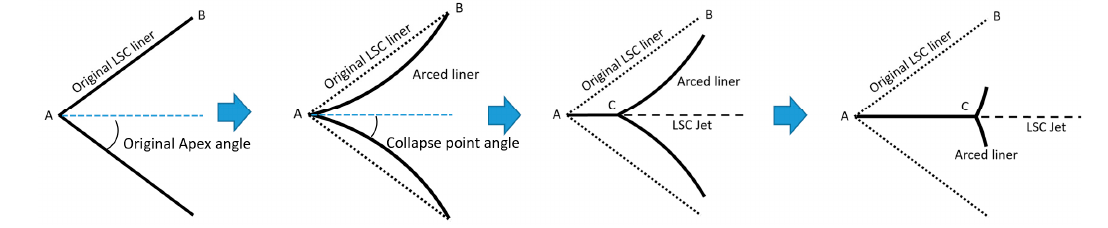
Figure 5. LSC liner collapse progress with arc deformation [13].